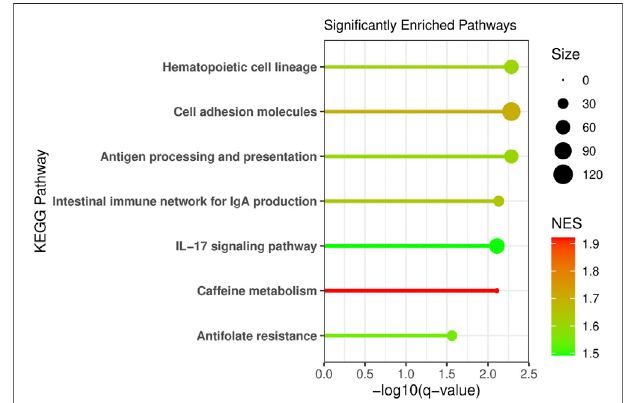
FIGURE 8 | Pathway Analysis Reveals Enrichment of Speci fi c Pathways for Differences Between Cell Lines. Pathway analysis was conducted using Gene Set Enrichment Analysis (GSEA) and the human Kyoto Encyclopedia of Genes and Genomes (KEGG) pathways. Genes were ranked by the absolute value of the Wald test statistic generated from the linear regression results. The KEGG pathway name is labeled on the y -axis, the − log10 of the q-value is plotted on the x -axis, the line and dot plotted are colored by the normalized enrichment score (NES) with the highest NES plotted in red and the lowest (from the signi fi cant pathways plotted) in green. The size of the dot in the fi gure represents the number of genes from our input that were in that speci fi c